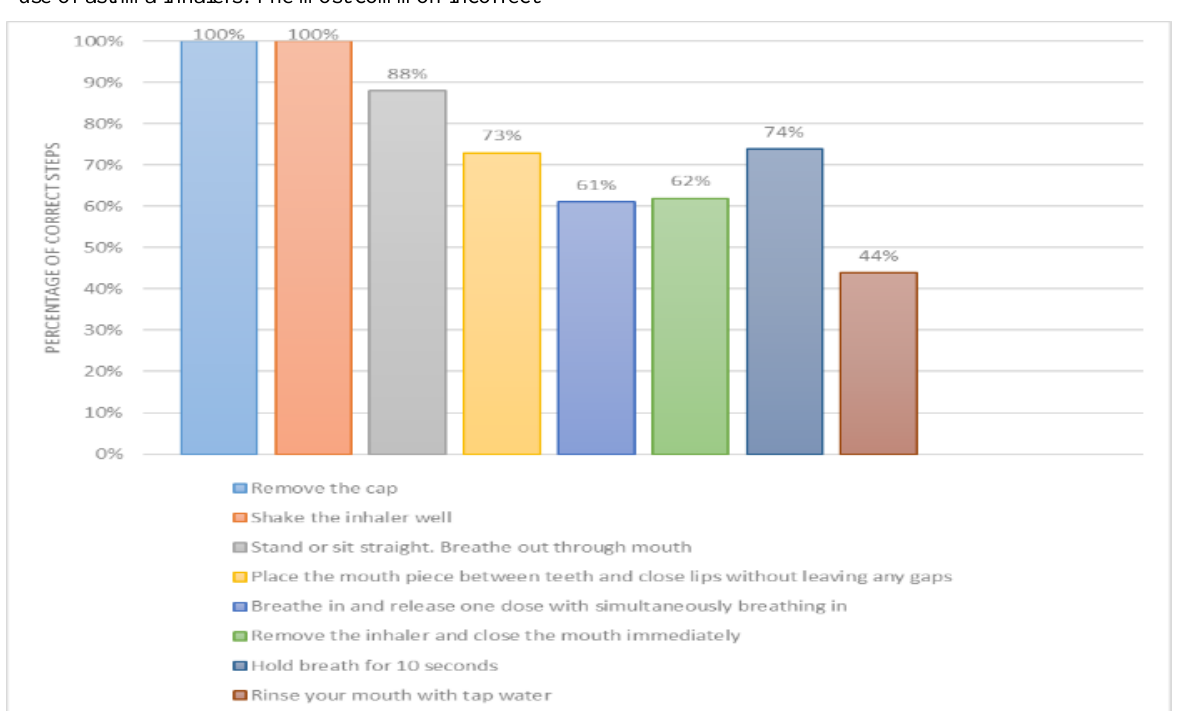
Figure 3. Steps of an Inhaler Technique error There was a significant (P-value<